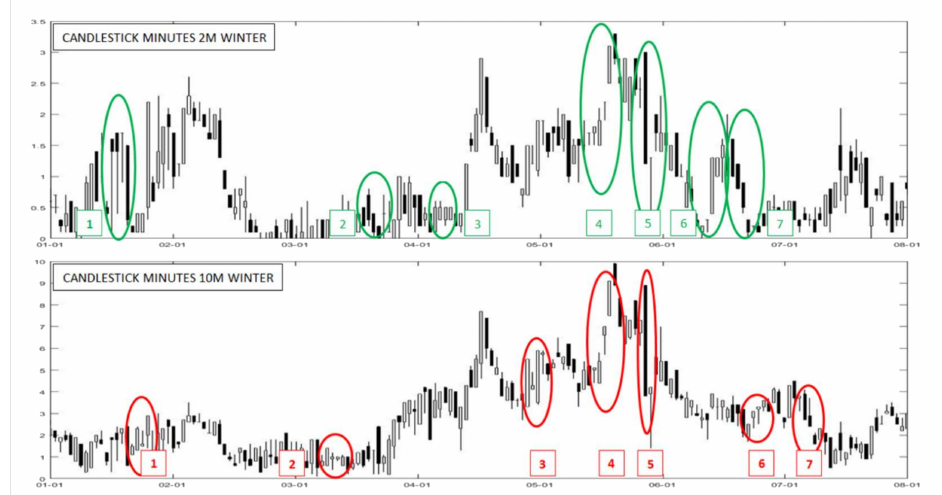
Figure 5. Candlestick chart for Los Montes del Cierzo, hourly resolution, first week of January 2017, at 2 m ( top ) and 10 m ( bottom ) above the